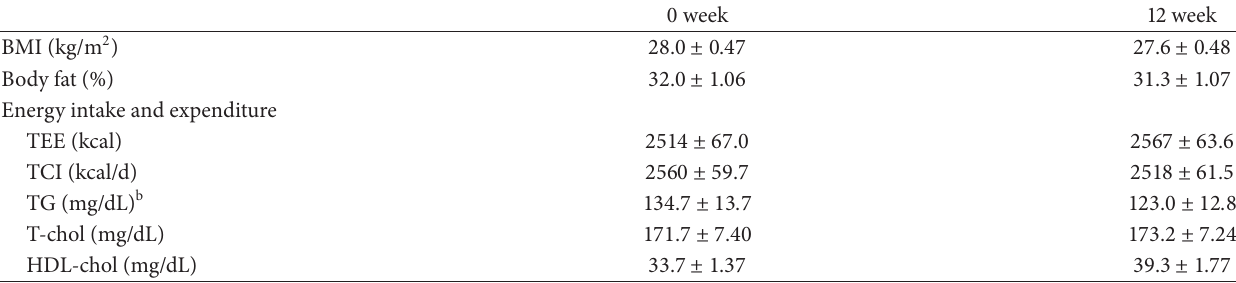
Table 1: Characteristics of BSP (black soybean peptides) controlled subjects before and after 12-week interventions a (data were adopted from Tables 1 and 2 in previous paper